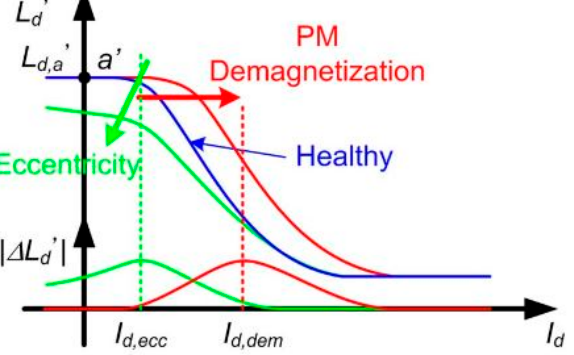
Figure 8. Variation in d -axis differential inductance L d and ∆ L d versus I d curves with PM demagnetization and eccentricity fault.